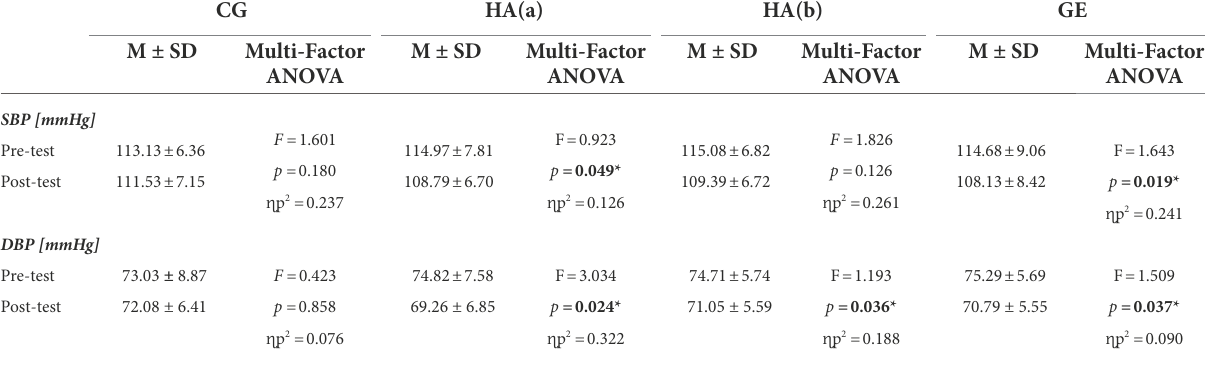
TABLE 1 Difference test results of BP indicators.